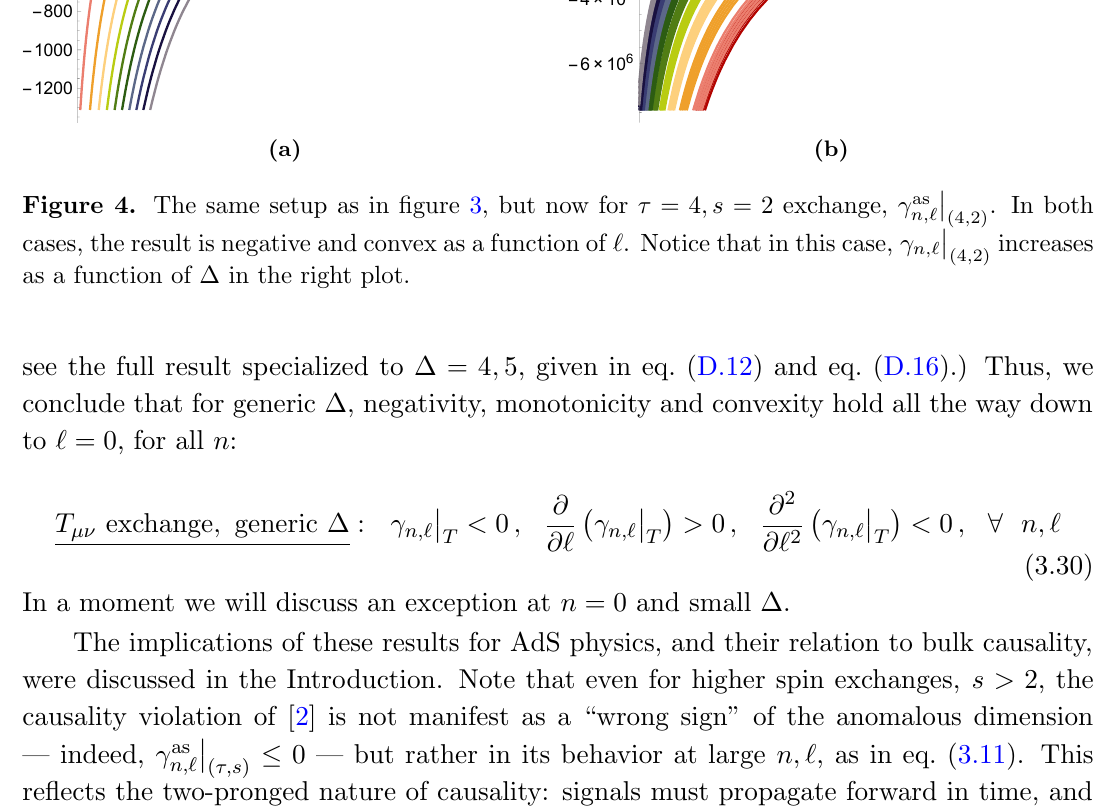
(cid:12) . In both (cid:12) n;‘ (4 ; 2) (cid:12) increases (cid:12) (4 ; 2)